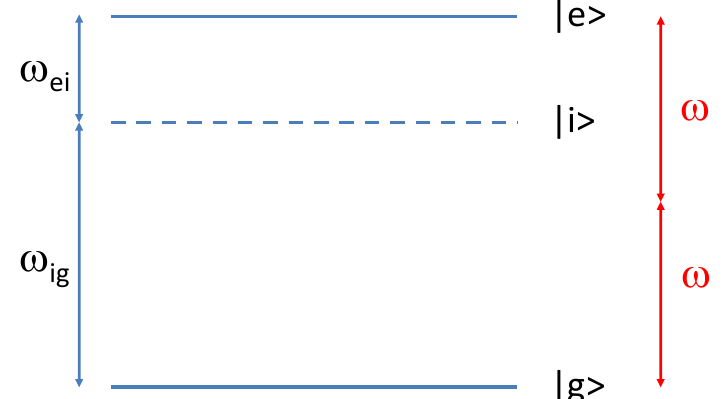
Figure 1. Schematic diagram of the atomic energy level structure in the two-photon model.